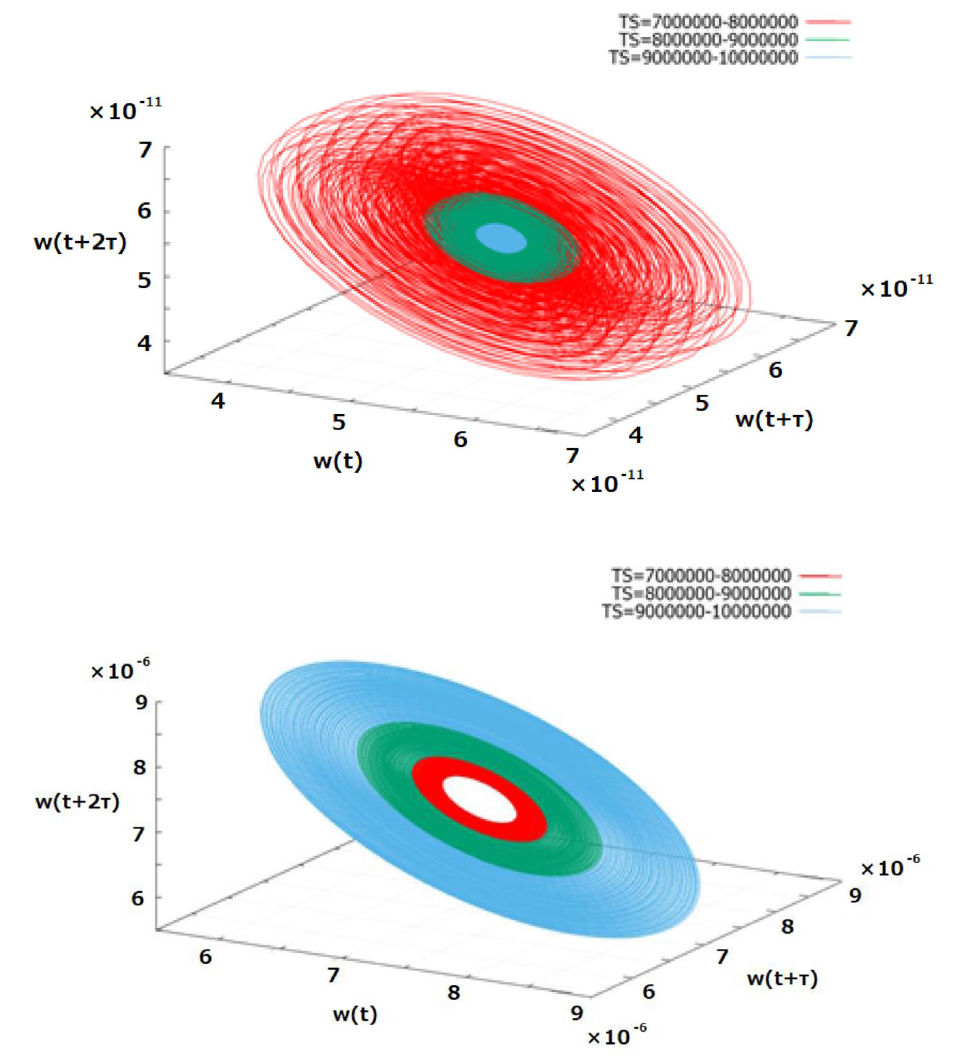
Fig. 8 Attractor of 2-vortex mode at Γ = 2.1, Re = 1660 (TS = 7 million to 10 million). The numerical dimensionless values 4 on the axes indicate 2.120160724 × 10 –2